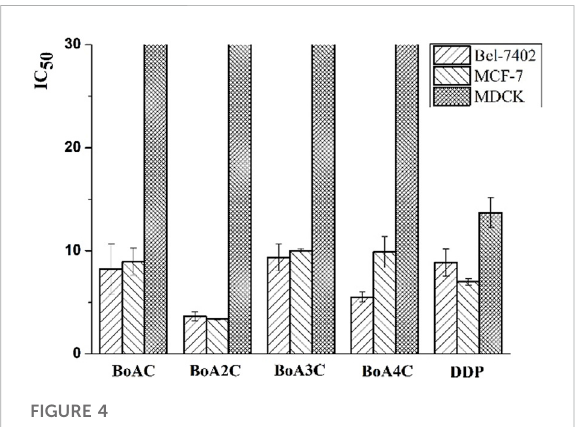
FIGURE 3 Comparison of cytotoxicity between BoAnG ( n = 2, 3, 4) and DDP.